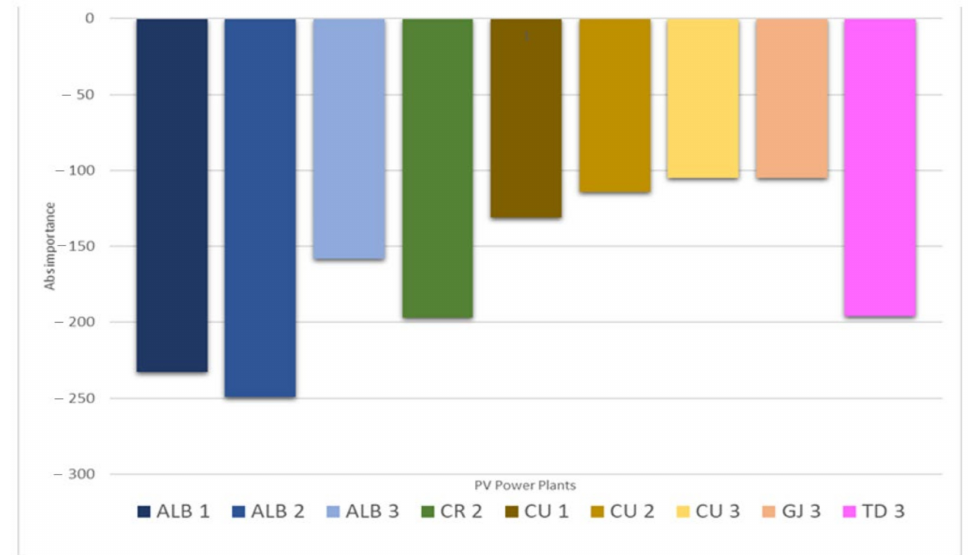
Figure 12. Representation of total absolute importance for different PV solar power plants in the operation